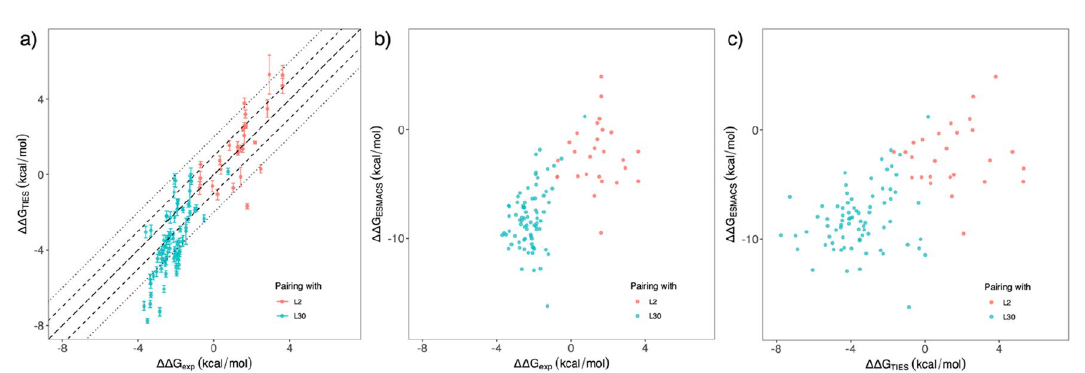
Figure 5. Comparison of relative binding affinities from ( a ) TIES and experiment, ( b ) ESMACS and experiment, and ( c ) TIES and ESMACS for the compound pairs studied in TIES. In subfigure ( a ), the long dashed, short dashed and dotted lines are y = x, y = x ± 1 and y = x ± 2. An excellent correlation is obtained between the TIES calculations and the experimental measurement, with a correlation coefficient of 0.90. Strong correlations are also obtained between ESMACS and experiment, and between TIES and ESMACS, with correlation coefficients of 0.67 and 0.62,